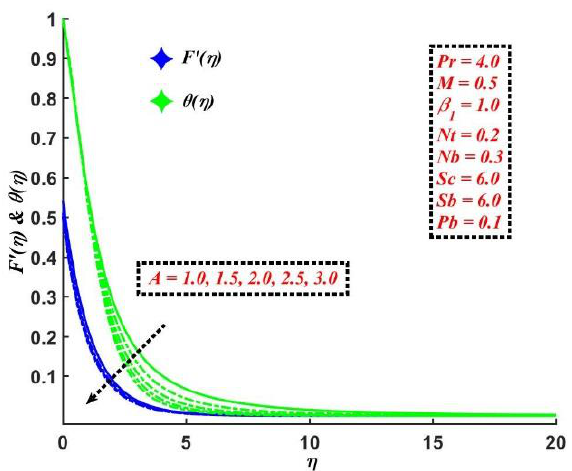
Figure 2. Influence of the curvature parameter on 𝐹 ′ (𝜂) and 𝜃(𝜂) .